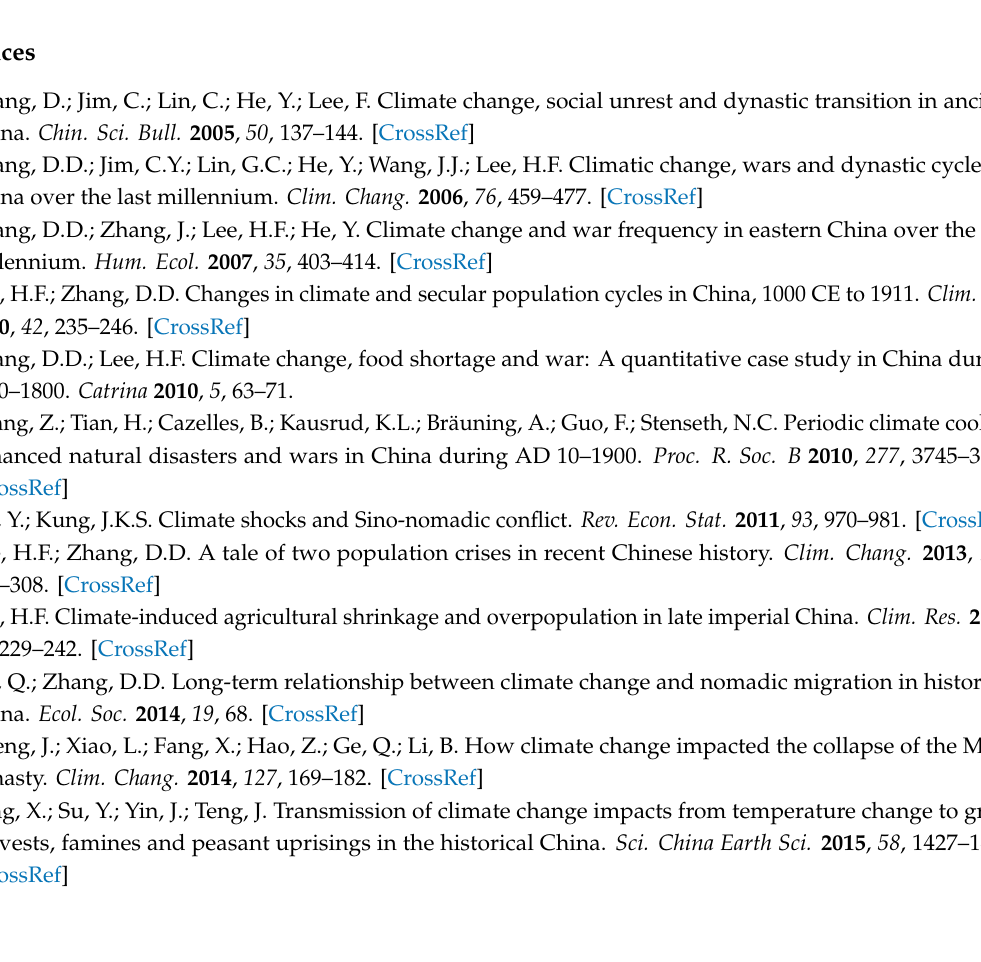
Figure S1: Comparisons of battle number counted within the grids of (a) 50 km, (b) 100 km, and (c) 200 km for each side of a cell, Figure S2: Geographical features of China mentioned in the main text, Table S1: History of China in the study period, Table S2a: N–S confrontation within China Proper during warm and cold phase, 5–1911 CE, Table S2b: N–S confrontation within China Proper during wet and dry phase, 1–1911 CE, Table S3: The